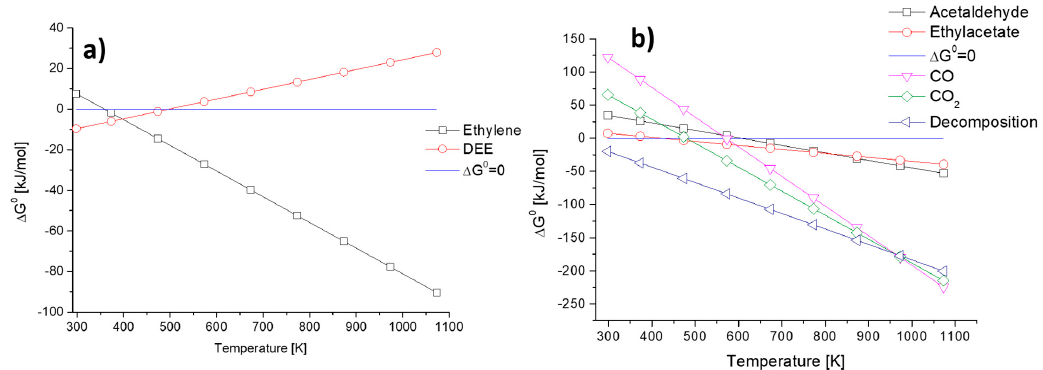
Figure 1. The ∆ G 0 of selected ethanol conversion reactions as a function of temperature: ( a ) ethylene and DEE-forming reactions and ( b ) acetaldehyde, ethyl acetate, CO, CO 2 and decomposition reactions.